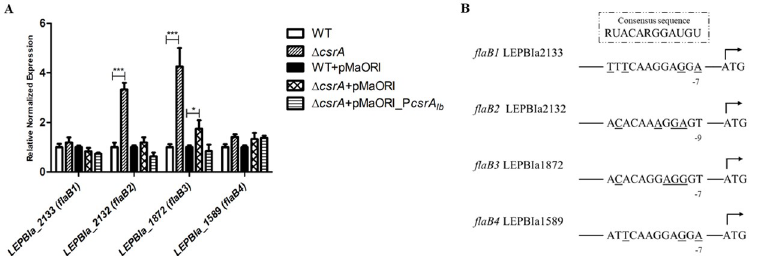
Fig 5. FlaB genes expression of L . biflexa . (A) Expression of L . biflexa flaB genes by RT-qPCR, RNAs were prepared from 3 independent cultures of each leptospiral strains. Results are presented as relative fold changes ± SEM using cysK for normalization. ( � ), ( �� ), and ( ��� ) indicate p-value < 0.05, < 0.01 and < 0.001, respectively. For statistical analysis, Δ csrA was compared to WT; Δ csrA +pMaORI or Δ csrA +pMaORI_P csrA lb was compared to WT+pMaORI. (B) Analysis of flaB 5’ untranslated regions of L . biflexa serovar Patoc. The gene and distances to the start codon are indicated. Underlined letters represent mismatched nucleotides compared with the consensus